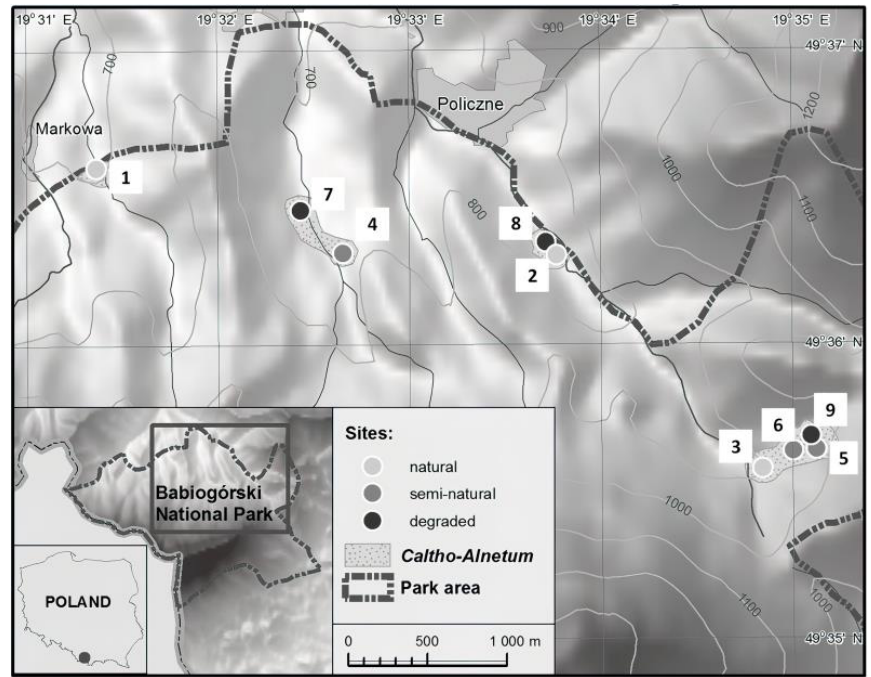
Figure 1. Location of the Babiogórski National Park in the Polish Flysh Outer Carpathians and location of the studied mountain fen Caltho-Alnetum sites with different degrees of artificial drainage (hydrologic condition, HC); 1–9 sites numbering. Acknowledgement: This figure was published in European Journal of Soil Biology, 68, Maria Sterzy´nska, Karel Tajovsk ý , Paweł Nicia, Contrasting responses of millipedes and terrestrial isopods to hydrologic regime changes in forested montane wetlands, 33–41, Copyright Elsevier